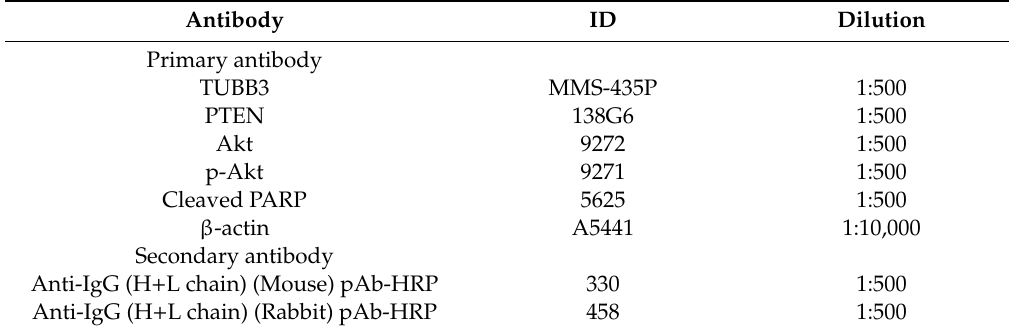
Table 1. ID and dilution of primary and secondary antibodies.